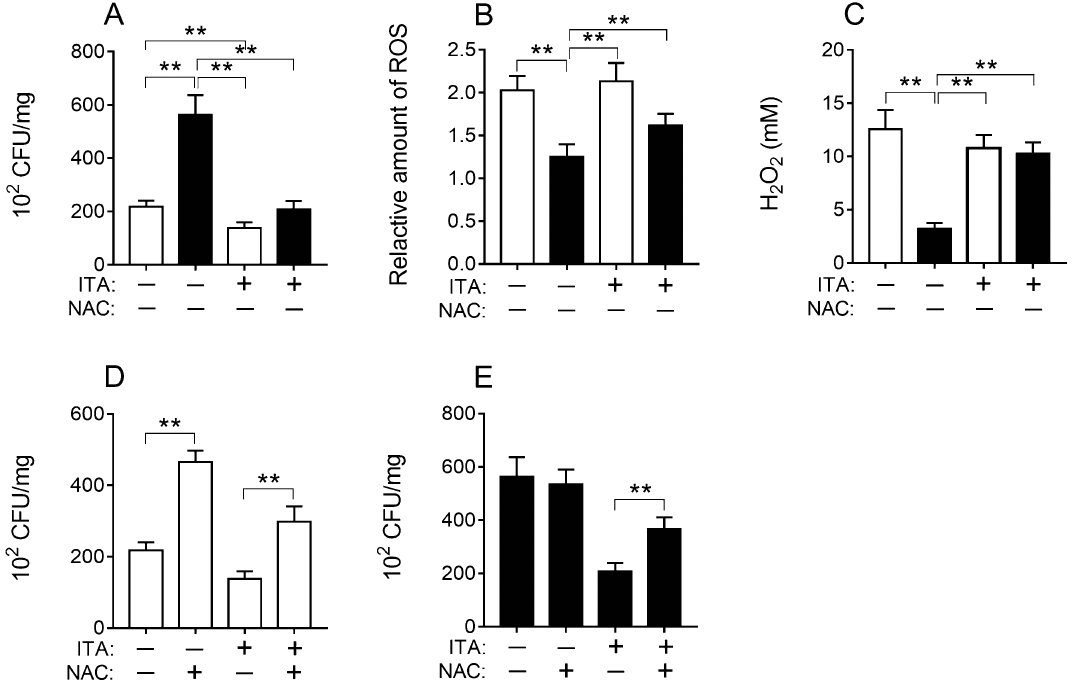
Figure 5. Growth of S. typhimurium in cells ( A , D , E ) and levels of ROS ( B ), H 2 O 2 ( C ) in S. typhimurium infected cells and culture medium under different treatment conditions (24 h). White bar, RAW264.7; black bar, RAW264.7-IRG1KO. ITA, itaconic acid; NAC, N -acetyl-L-cysteine. Relative ROS amount in cells with different treatments was normalized to RAW264.7 control (NAC) and represents the fold change. Values represent the mean ± S.E.M. **, p <